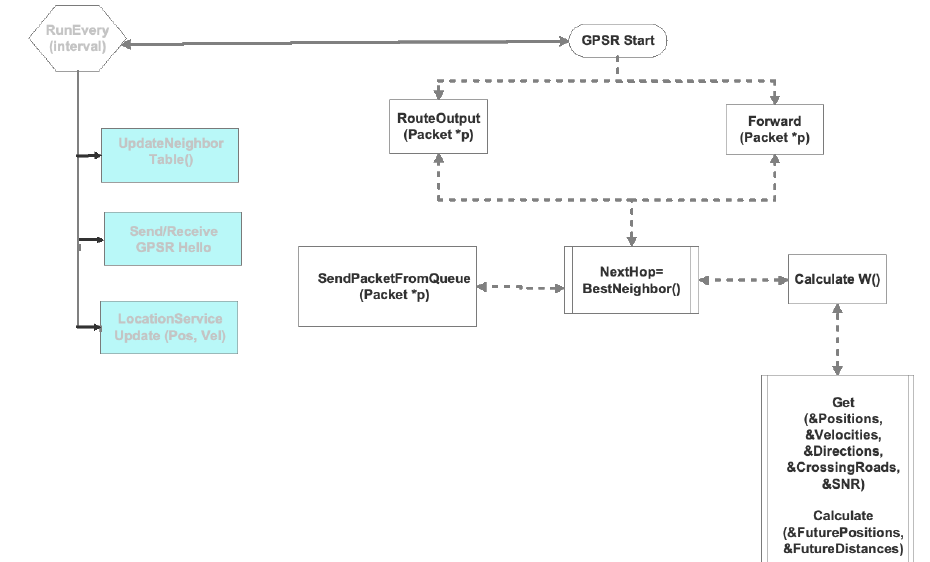
Figure 12. Mechanism procedure of greedy perimeter stateless routing (GPRS)-modified (GPSR-M)